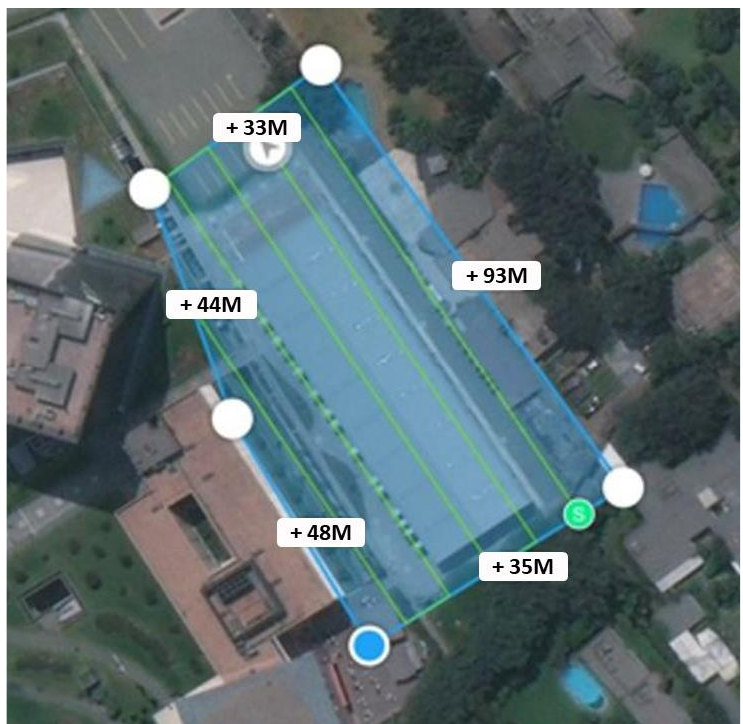
Figure 16. UAV Matrice 600 flight plan using the Ground Station Pro (GSP) software. From the data obtained from the UAV positions provided by the GPS geodetic sys- tem, we obtained the path followed in the UTM system. Figure 17 is the result of the georeferencing equation in the UTM Reference System after the conversion performed in Figure 13. The X -axis is the equator, and the Y -axis is the meridian. The complete path followed by the UAV is expressed in UTM coordinates for X, Y, and WGS84 for Z.